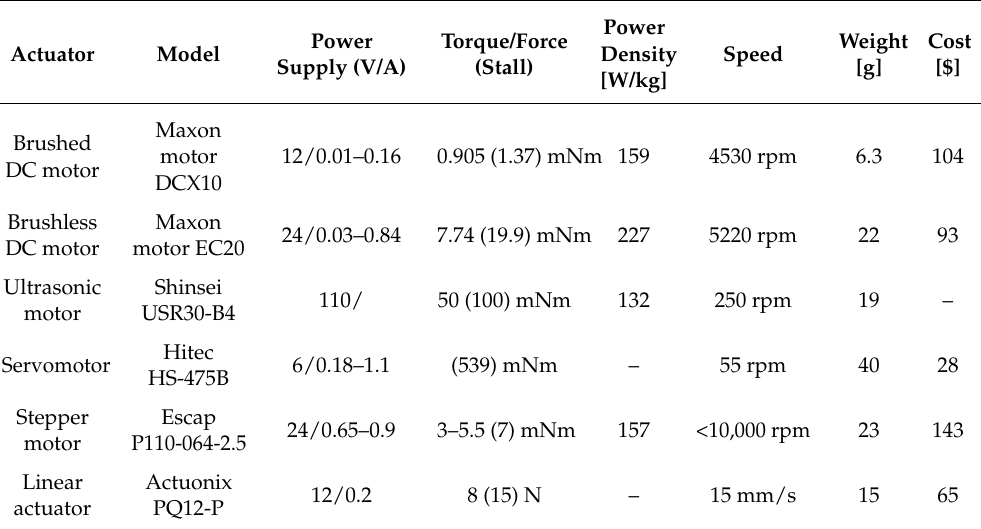
Table 2. Comparison of motor-based